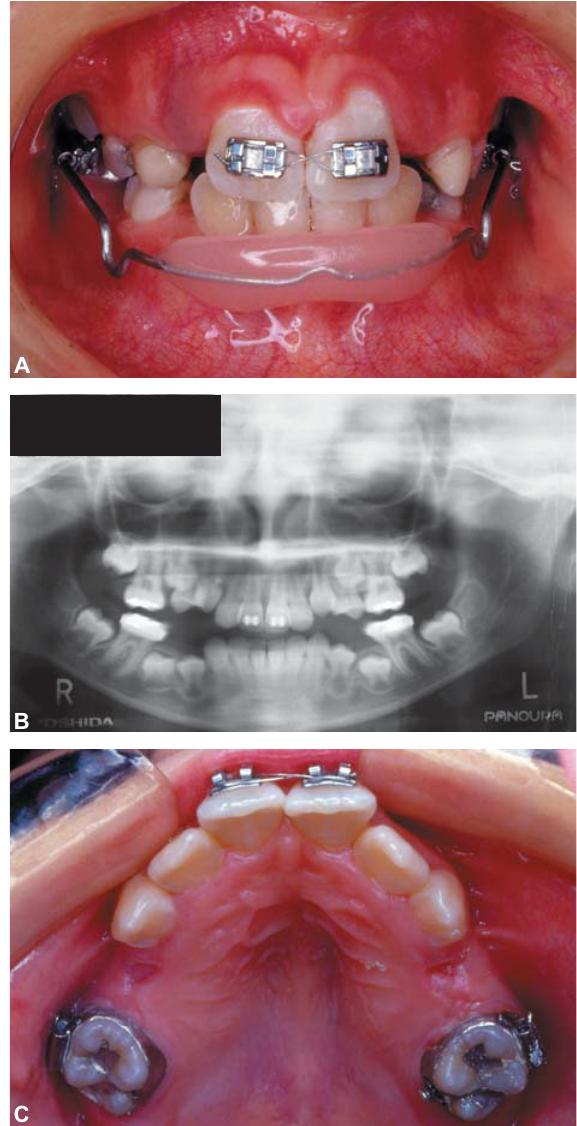
Figure 4- Intermediate phase showing the anchorage preparation in the upper arch, and the reduction of the diastema